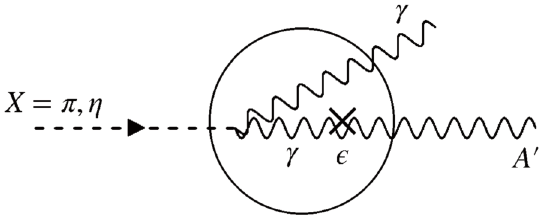
Figure 5. Effective vertex for the decay process X → γA 0 , X = π 0 , η